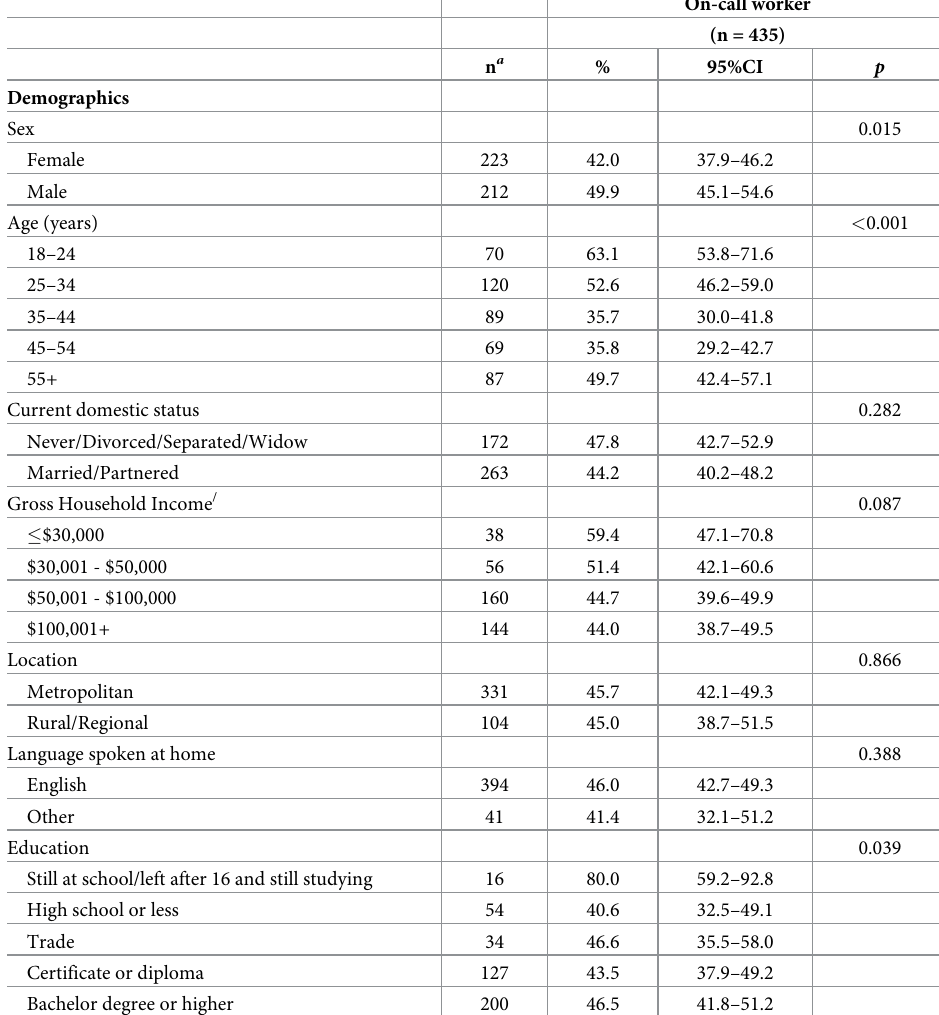
Table 1. Prevalence of on-call work within sociodemographic